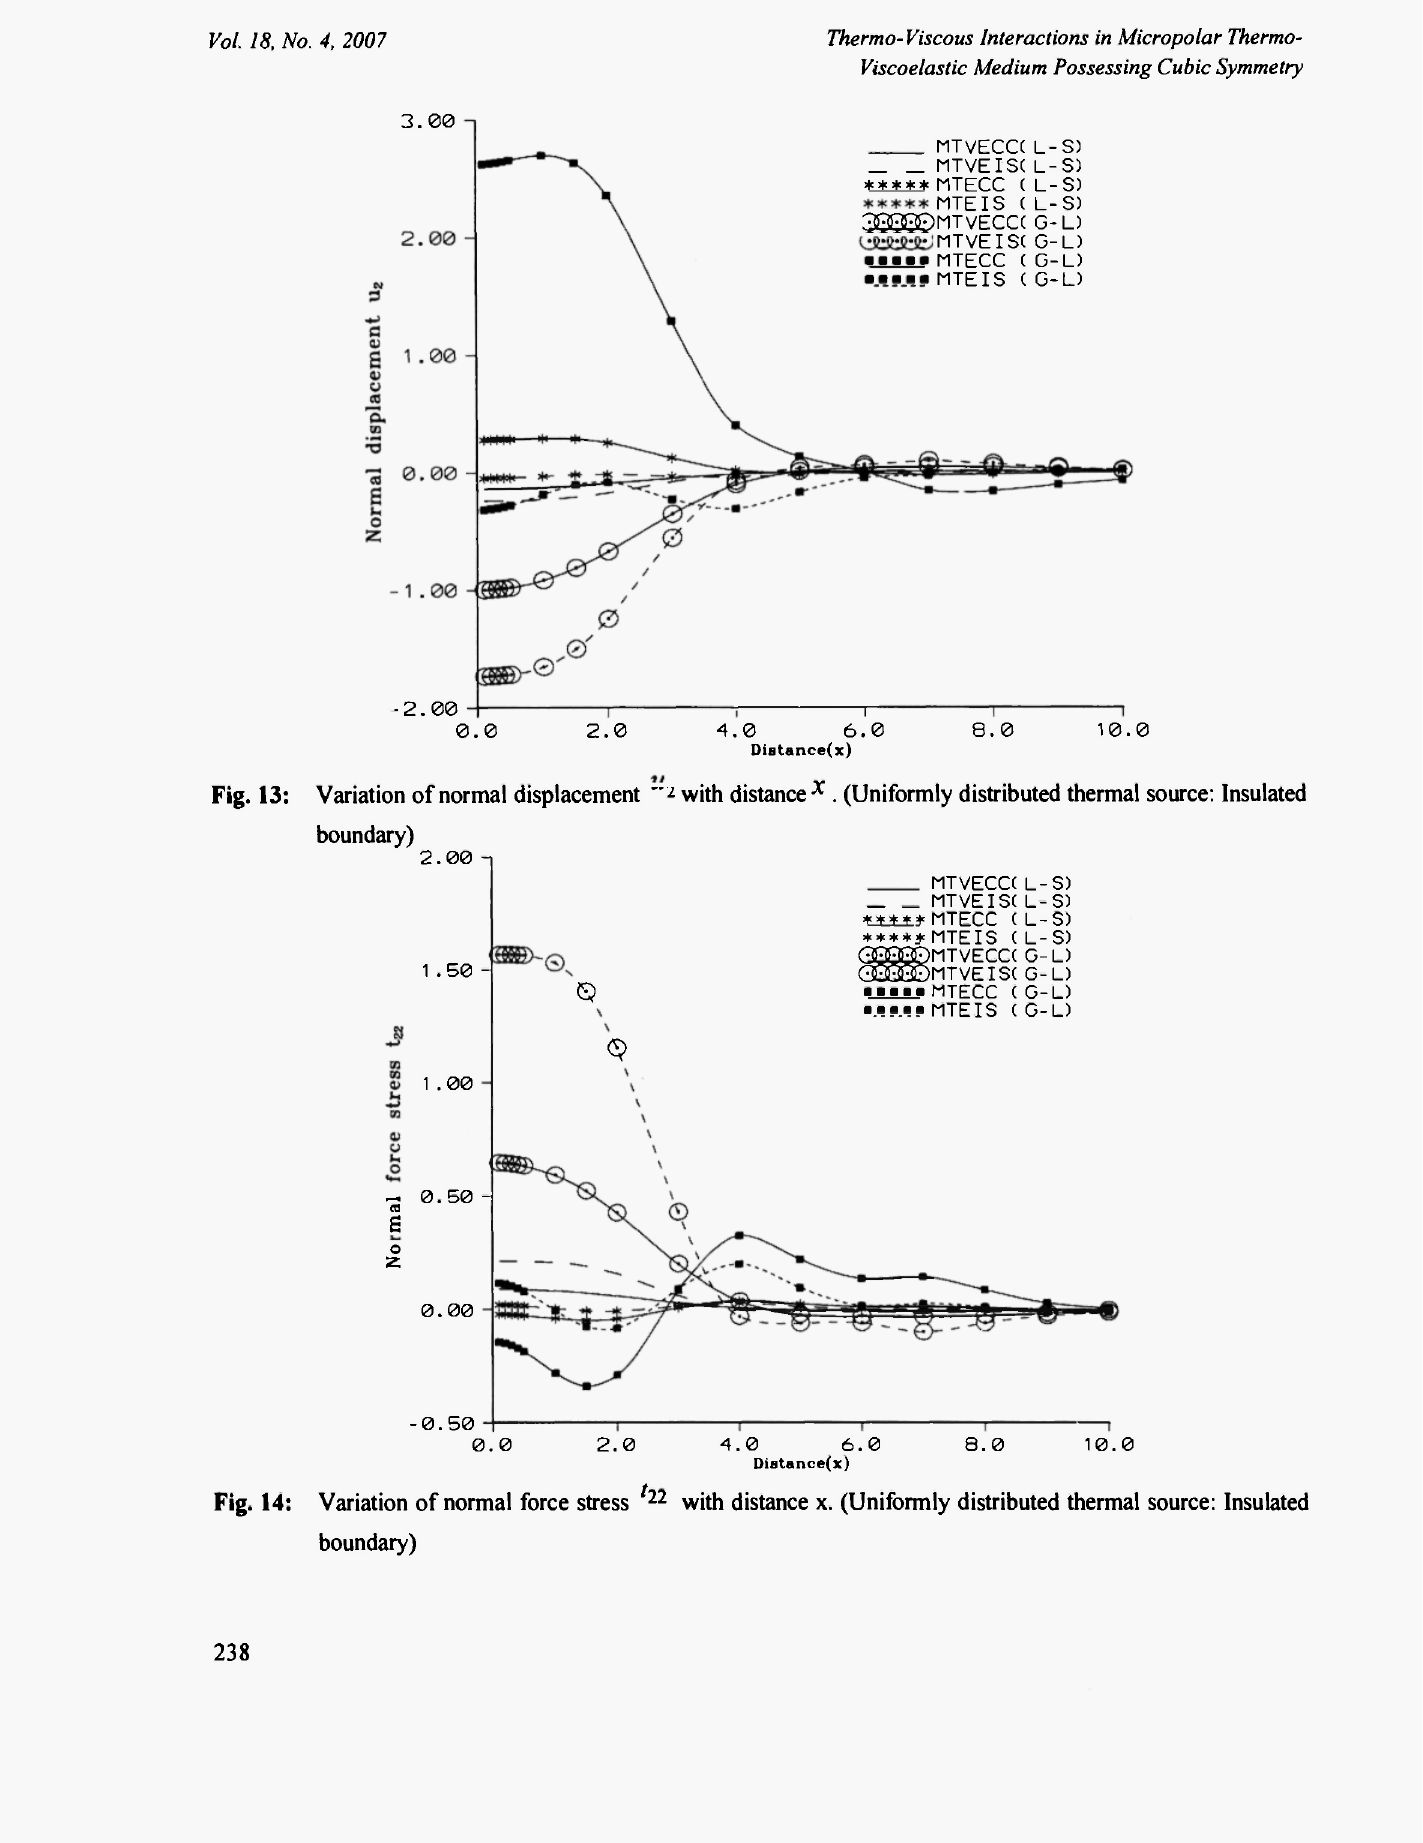
Fig. 13: Variation of normal displacement with distance x . (Uniformly distributed thermal source: Insulated boundary) 2.00-1